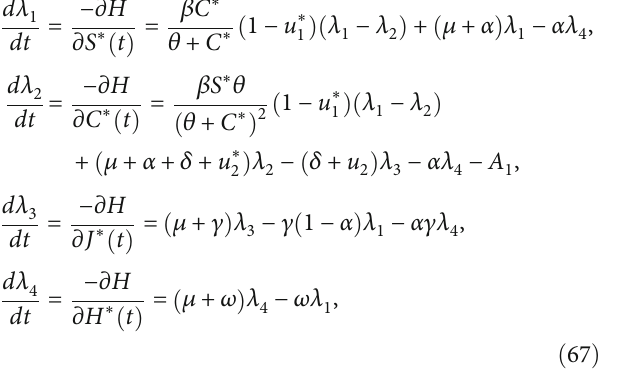
Figure 7: Simulation showing the optimal solution for susceptible, corrupt, jailed, and honest via use of u and α = 0 : 021